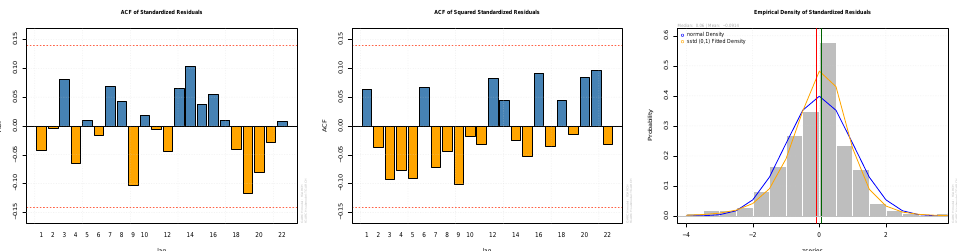
Figure 2. Histogram and ACF of standardized residuals of the ARMA-TGARCH model for BCI time series. Red lines correspond to Bartlett’s bands related to 95% confidence level.